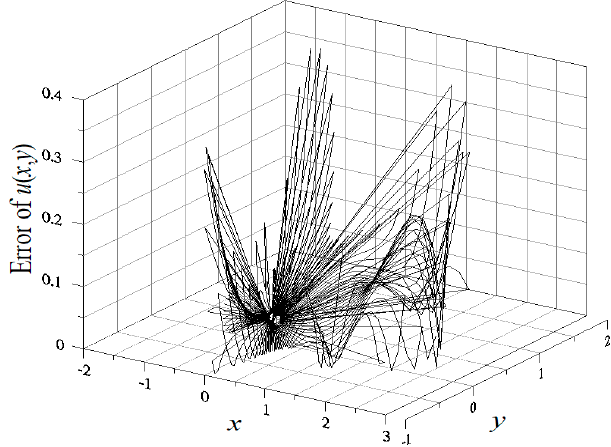
Figure 10. The numerical solutions for the steady-state AC equation with amoeba-like irregular domain are shown in ( a ), and in ( b ) the proposed approach solution with random noise.